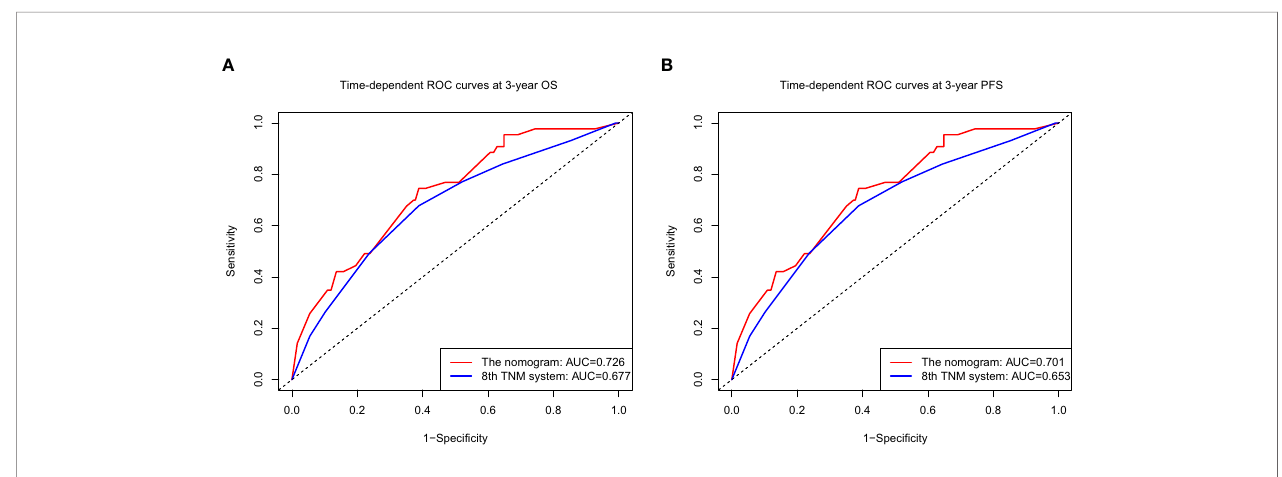
FIGURE 3 | The time-dependent receiver operating characteristic (tdROC) curves of OS (A) and PFS (B) at 3 year by the nomogram and the eighth UICC/AJCC TNM staging